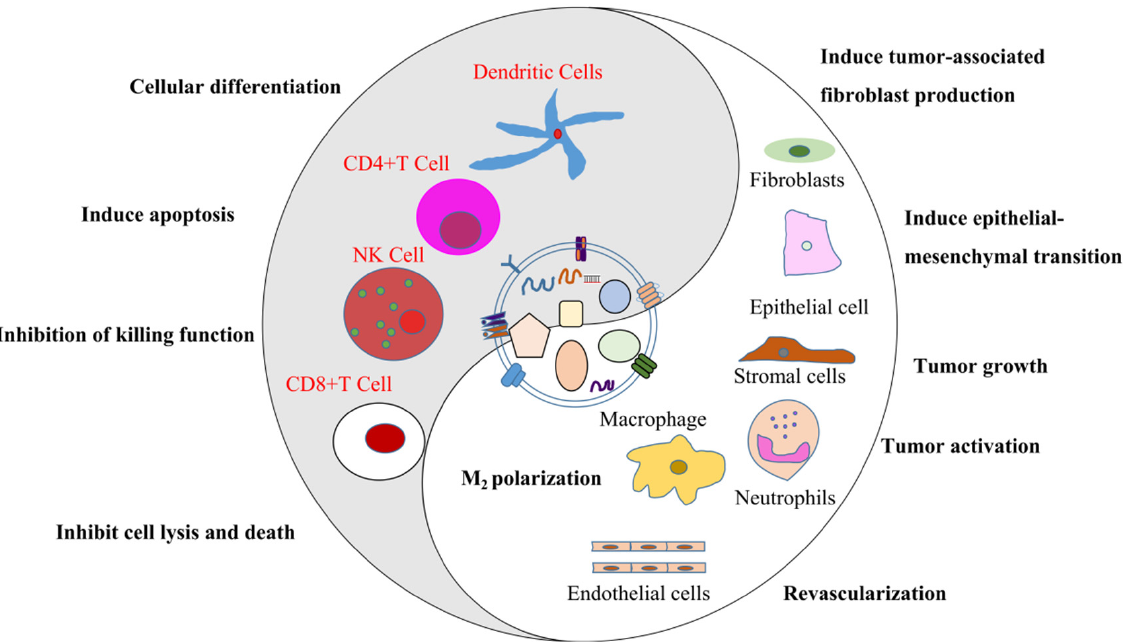
Figure 3. The schematic diagram of the relationship between tumor-related exosomes and tumors. Tumor-derived exosomes directly induce immune tolerance by transmitting inhibited or apoptotic signals to immune cells, indirectly affecting immune cells’ development, maturation, and anti-tumor activity. These exosomes alter the function of the responding cells by passing miRNA/mRNA/DNA to immune cells, polarizing macrophages into M2 type that accelerates tumor progression, converting normal fibroblasts into tumor-associated ones, promoting angiogenesis of endothelial cells, inhibiting the killing function of natural killer (NK) cells, and by triggering the differentiation of dendritic cells to promote the occurrence and development of